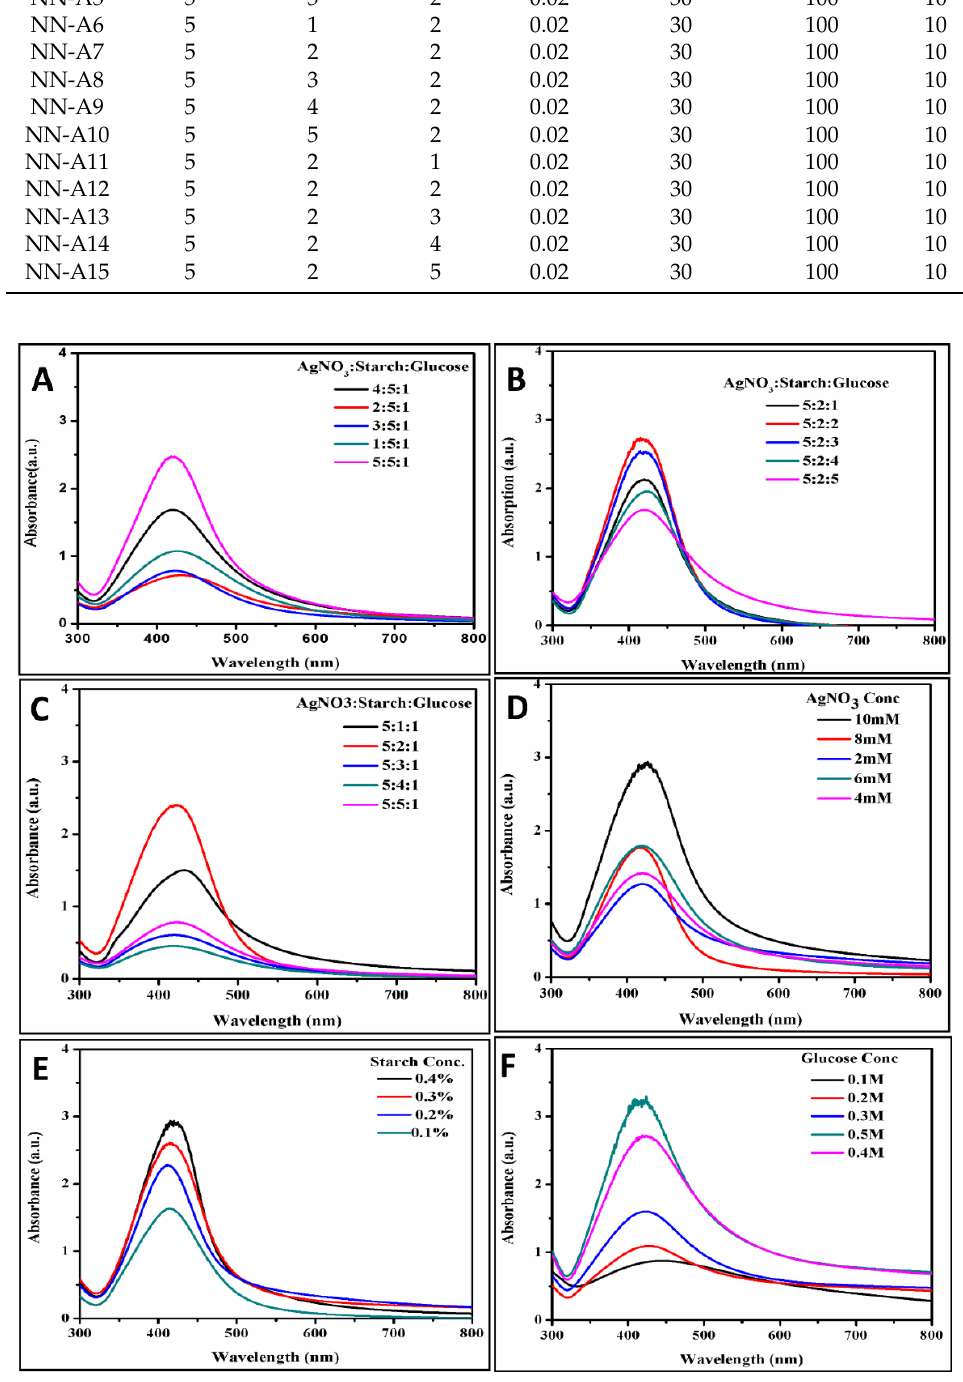
Figure 2. UV spectra relating to AgNPs’ formation at diverse volume ratios of ( A ) 10 mM AgNO 3 (1 to 5 mL), ( B ) 0.1 M glucose, ( C ) 0.2% starch, and ( D ) at 5 mL of different concentration of AgNO 3 , ( E ) at 2 mL of various concentrations of starch, ( F ) at 2 mL of various concentrations of glucose. Table 2. Experimental details for different concentrations. of AgNO 3 , glucose, starch, and KOH in The concentration of AgNO 3 (NN-A16 to NNA-20) varied from 2 to 10 mM, while the the synthesis of AgNPs. concentration of glucose (NNA-21 to NNA-25), starch (NN-A26 to NN-A30), and